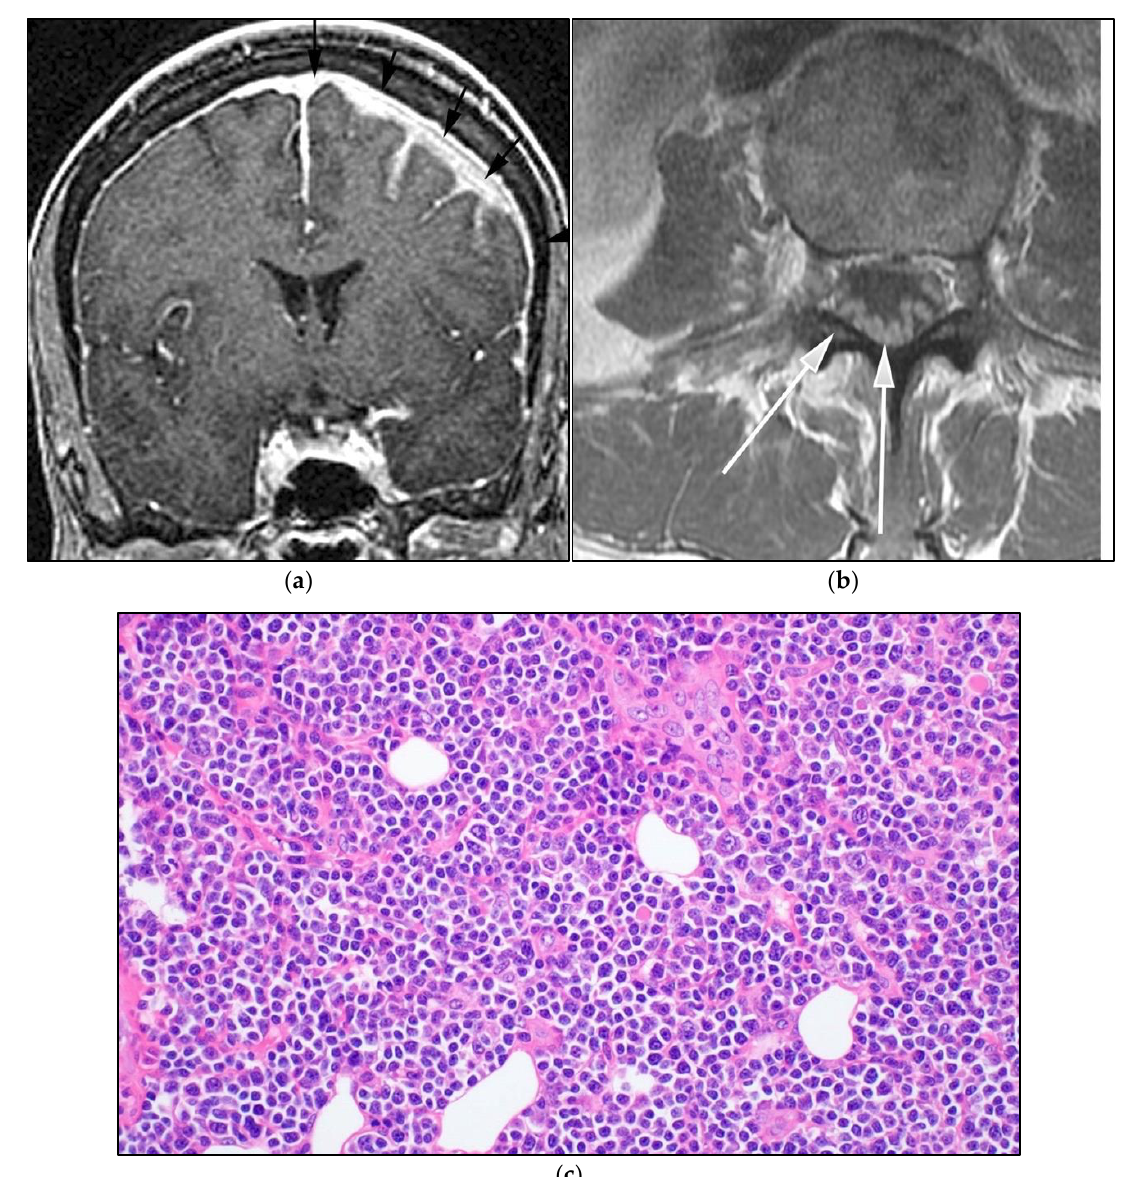
Figure 12. Lymphoplasmacytic lymphoma. ( a ) Axial FDG PET/CT in the same patient as Figure 8 shows hypermetabolic adenopathy within the bilateral iliac chain (white arrows). ( b ) Sagittal MRI T1-weighted image in the same patient shows a diffuse variegated appearance of the marrow consistent with marrow infiltration as that seen in multiple myeloma but without definite focal lytic lesions. Lymphoplasmacytic lymphoma combines features of both malignant lymphoma and multiple myeloma.